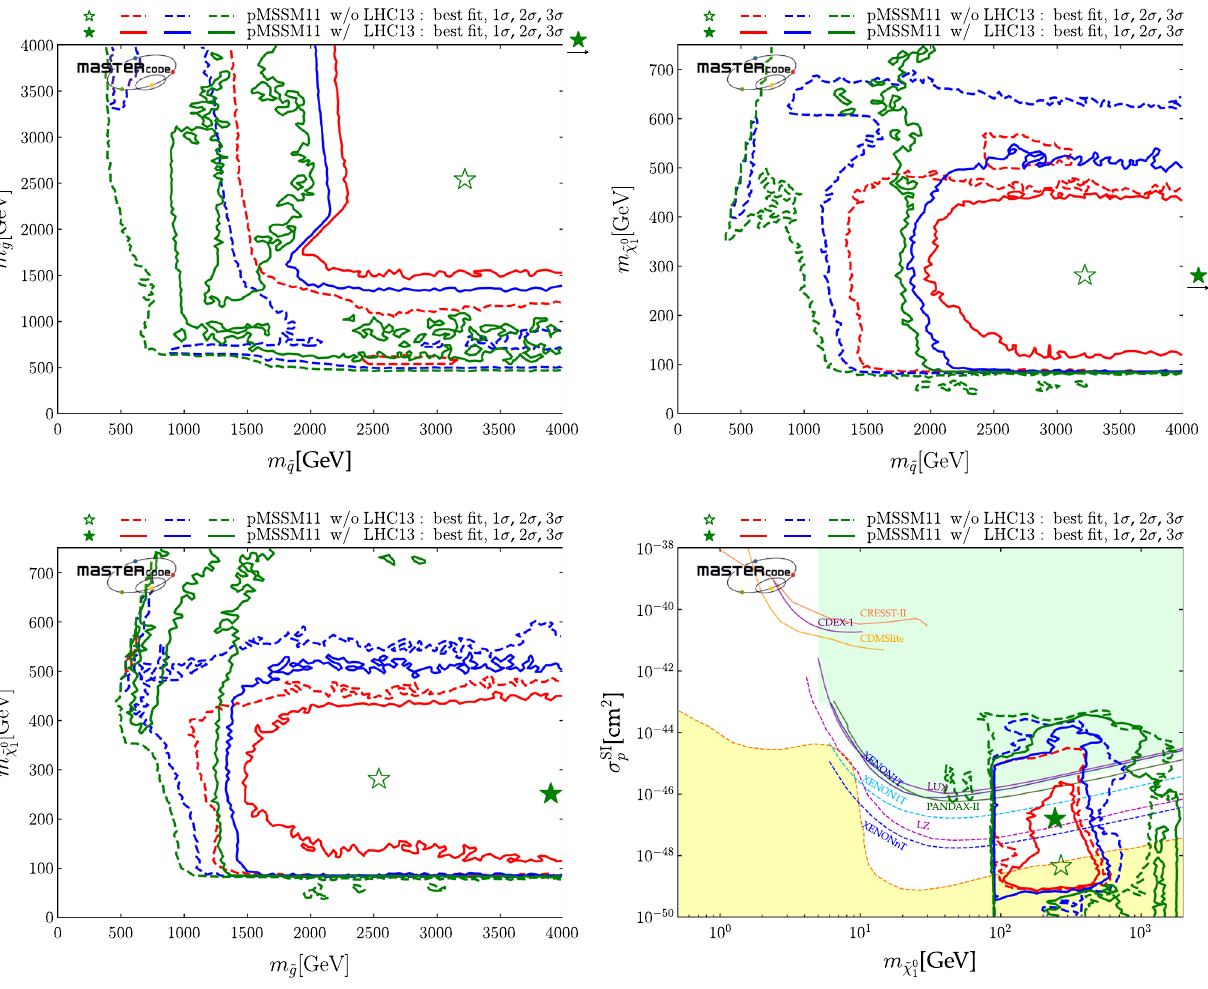
Fig. 22 Two-dimensional projections of the global likelihood func- at the 68% (red lines), 95% (blue lines) and 99.7% CL (green lines) ) planes (upper tion for the pMSSM11 in the ( m ˜ q , m ˜ g ) and ( m ˜ q , m ˜ χ 0 in a global fit including the LHC 13-TeV data and recent results from 1 the Xenon-based direct detection experiments LUX, XENON1T, and ) and ( m ,σ SI ) planes (lower panels). The panels) and the ( m ˜ g , m ˜ χ 0 ˜ χ 0 p PandaX-II [3,4,6] (solid lines), and omitting them (dashed 1 1 plots compare the regions of the pMSSM11 parameter space favoured